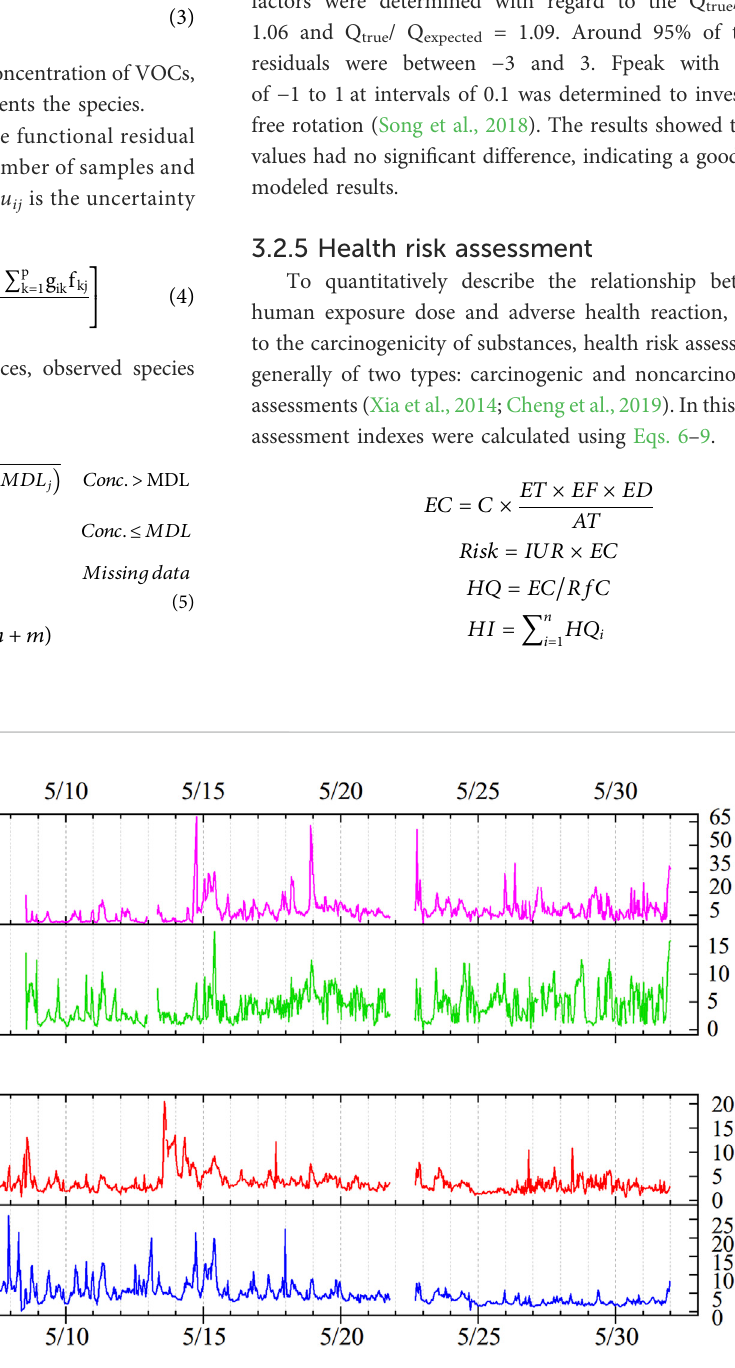
Time series variations in alkenes, C2 – C5 alkanes, C6 – C12 alkanes, and aromatics mixing ratios in the 2019